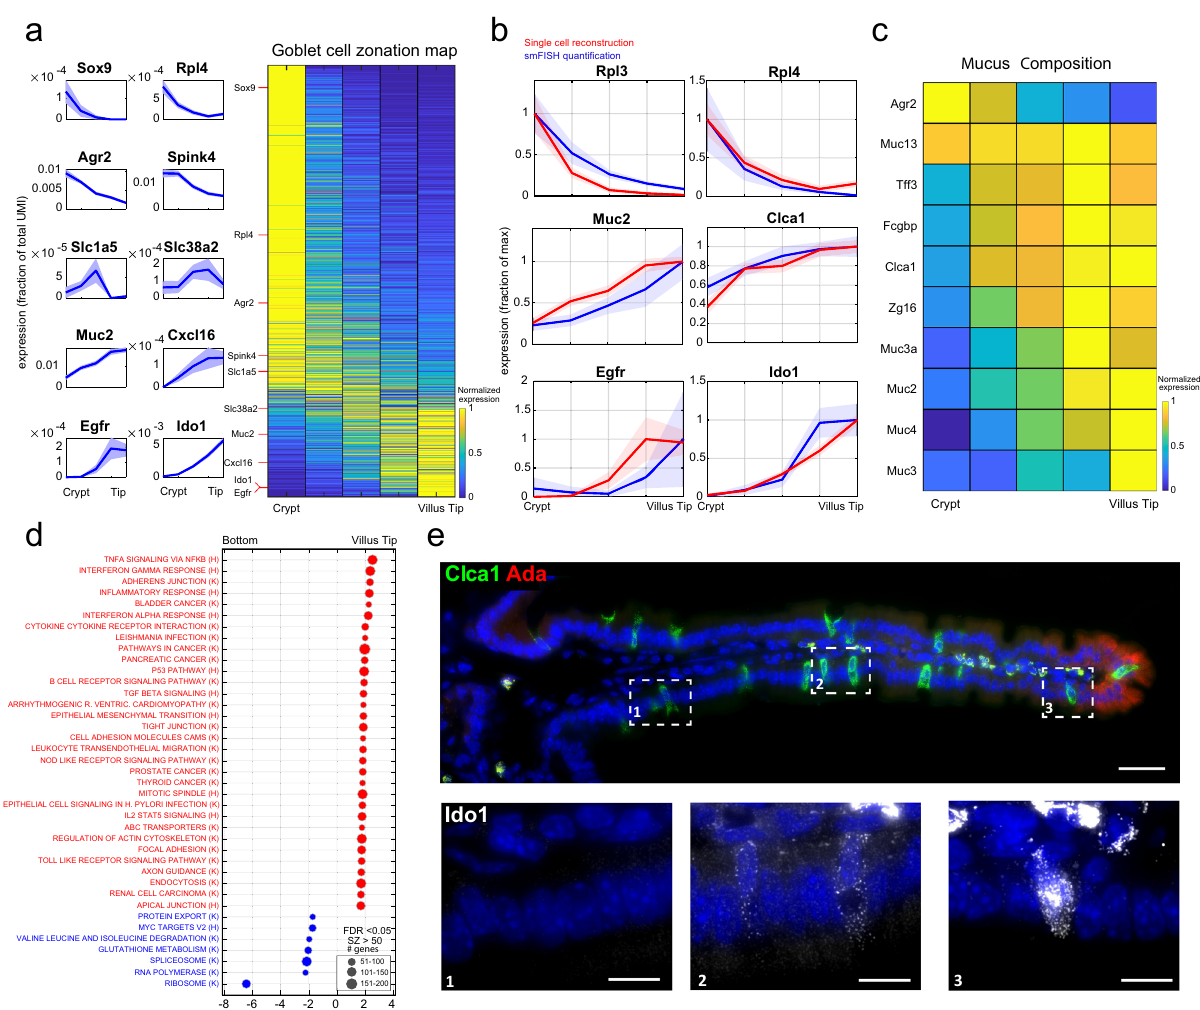
Fig. 3 Spatial reconstruction of goblet cells. a Reconstructed zonation pro fi les based on single goblet cells. Pro fi les are normalized to their maximum across zones. Plots on the left show zonation pro fi les of representative crypt (Sox9, Rpl4, Agr2, Spink4), mid-villus (Slc1a5, Slc38a2) and villus tip (Muc2, Cxcl16, Egfr, Ido1) genes. Light areas denote the SEM. b Validation of the reconstructed zonation pro fi les using smFISH. Blue line shows smFISH mean expression level, red line the reconstructed pro fi le based on the single cell analysis. Light patches denote the SEM. Source data are provided as a Source data fi le. c Heatmap of zonation pro fi les of genes related to mucus composition. Pro fi les are normalized to their maximum across zones. d Gene set enrichment analysis 53 for hallmark (H) and KEGG (K) pathways (FDR < 0.05), tip enriched sets are in red, bottom enriched sets are in blue. e smFISH image of zonated genes Clca1 (green) and Ido1. Ada (red) marks the villus tip, blue the DAPI-stained nuclei. Bottom insets show Ido1 mRNAs (gray dots) increasing from the bottom (1) to middle (2) and tip (3) villus zones. Images representative of n = 10 villi (5/mouse). Scale bar, 50 μ m in the stitched image and 15 μ m in the